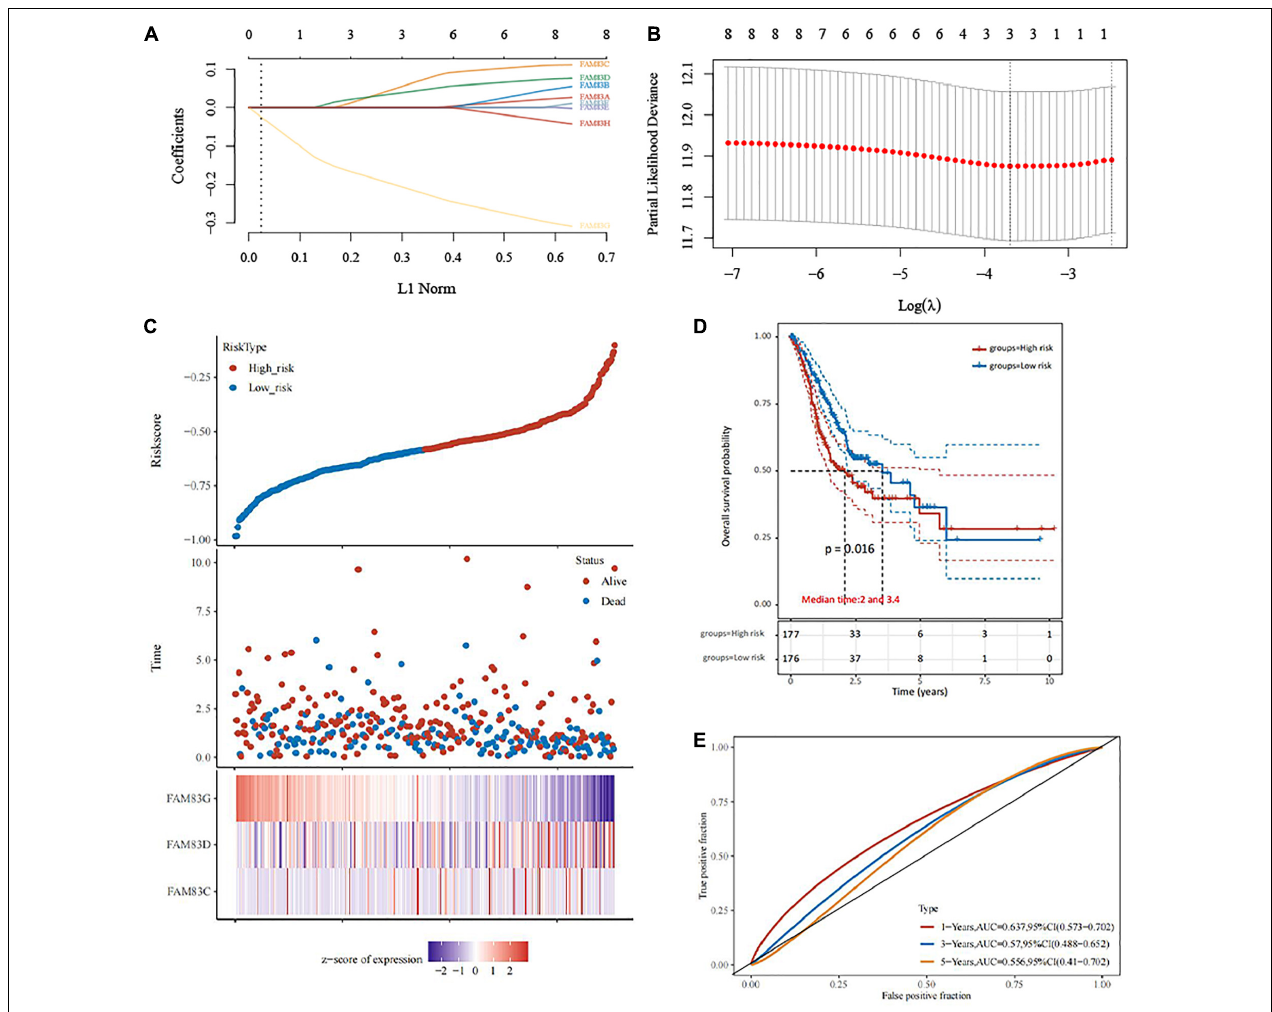
FIGURE 9 | The construction of prognostic model of gene signature from FAM83 family in STAD (TCGA)by LASSO analysis. (A) Coefficients of selected features are shown by lambda parameter. (B) Partial likelihood deviance vs. log ( λ ) was drawn using LASSO Cox regression model. (C) The relationship between survival status—risk score rank and expression of FAM83 family. (D) Kaplan–Meier survival plots of the two groups (high risk and low risk). (E) ROC curves of the survival model in